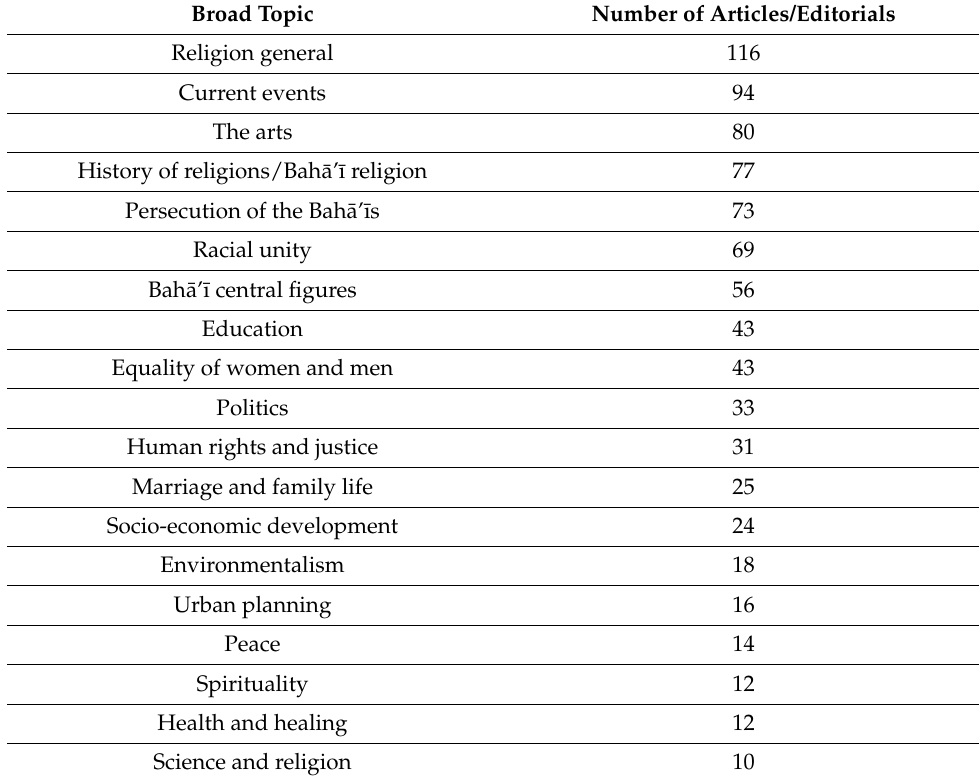
Table 1. Number of articles in World Order by